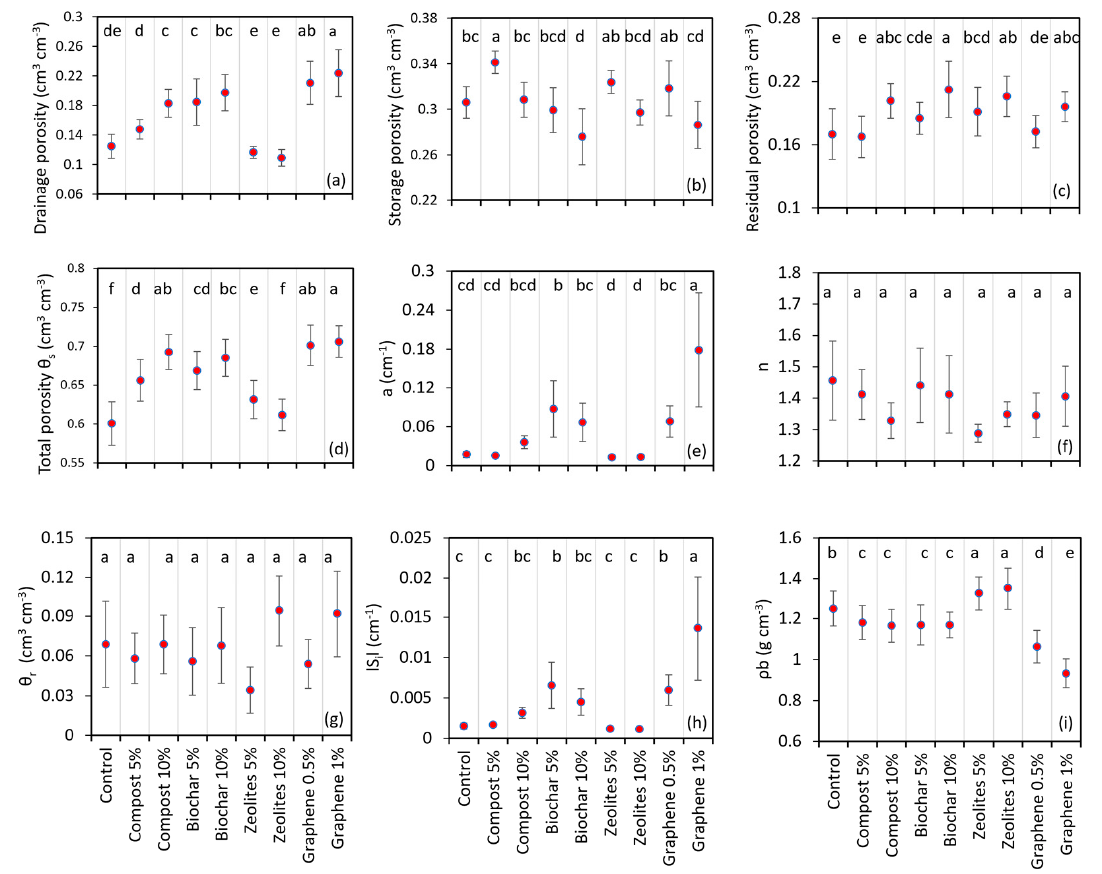
Figure 3. Mean ± S.E. of drainage (a), storage (b), residual (c), and total (measured θ s ) porosities (d), fi tt ed van Genuchten parameters (e to h), and ρ b (i) with the statistical LSD comparison between treatments based on all soils for each parameter. Di ff erent scales of the y axis were used to clarify the graphs. The same le tt er indicates no statistical di ff erences among treatments.